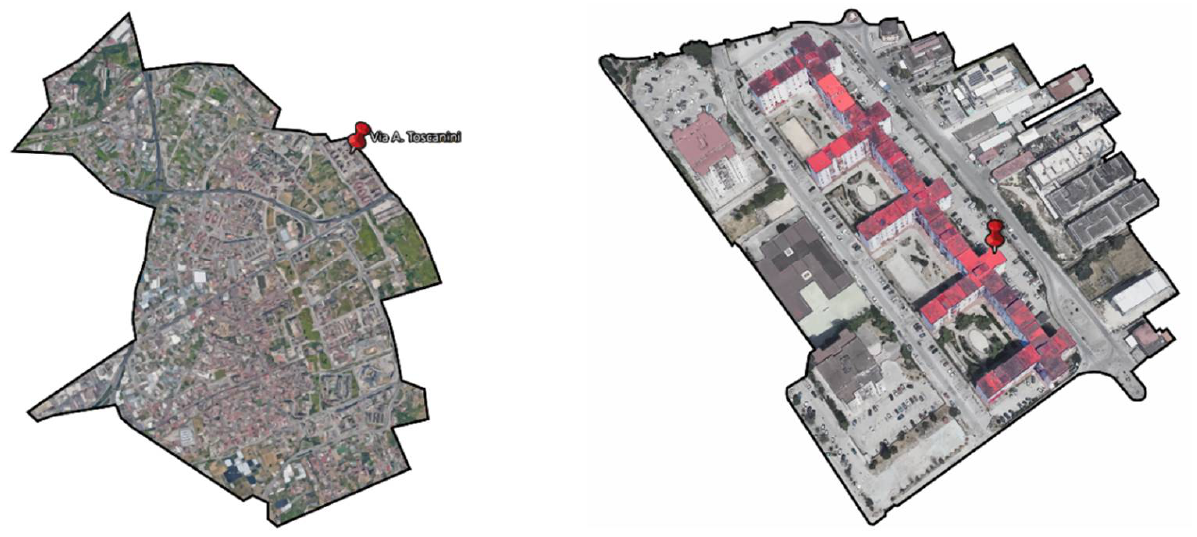
Figure 4. Identification of the Ponticelli district and the area and building of interest.